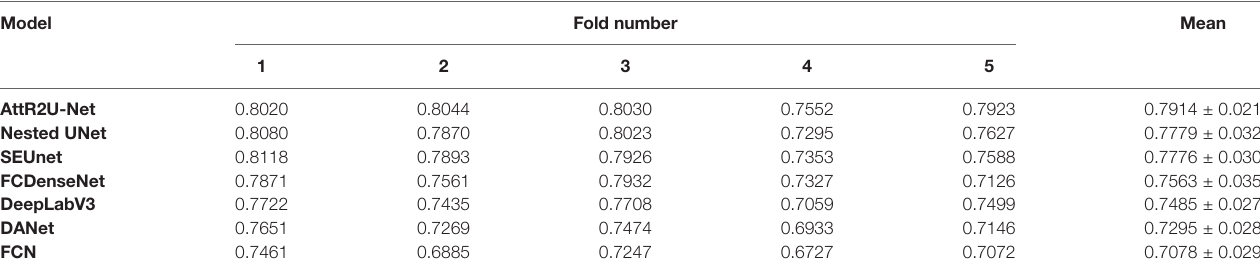
TABLE 3 | Results (DSC value) of model comparison experiments using patient-wise 5-fold cross validation.